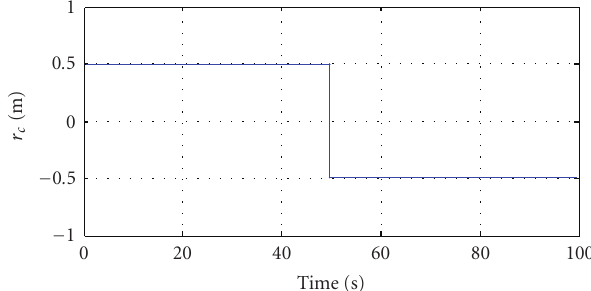
Figure 6: System responses with K implementation (position of cart x c is shown instead of cart position error e x ).